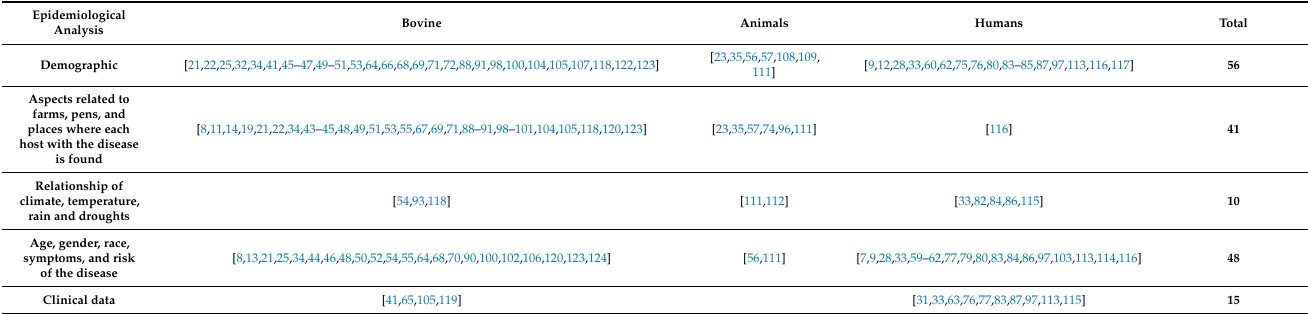
Table 3. Result of comparing related job–epidemiological analysis group.